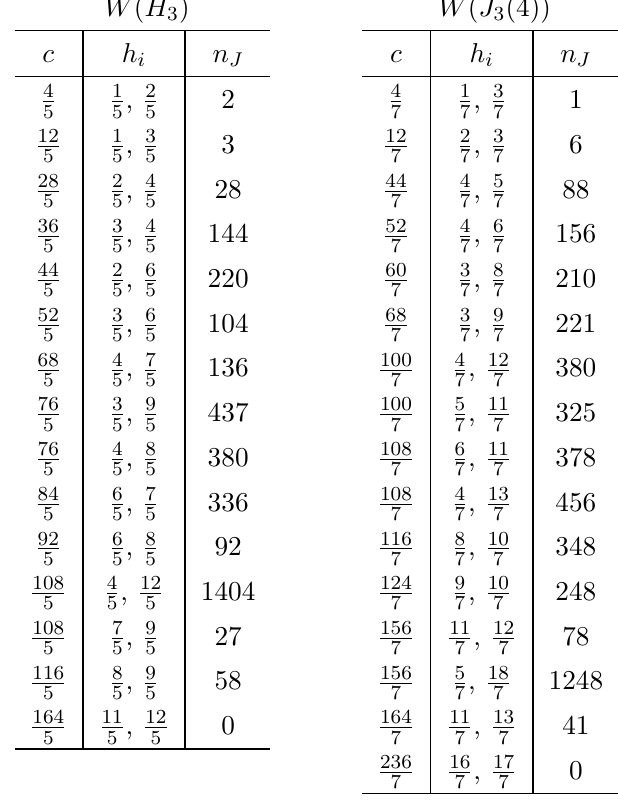
Table 10 . Possible three-character ‘ = 0 theories with primitive monodromy group. Compare with table